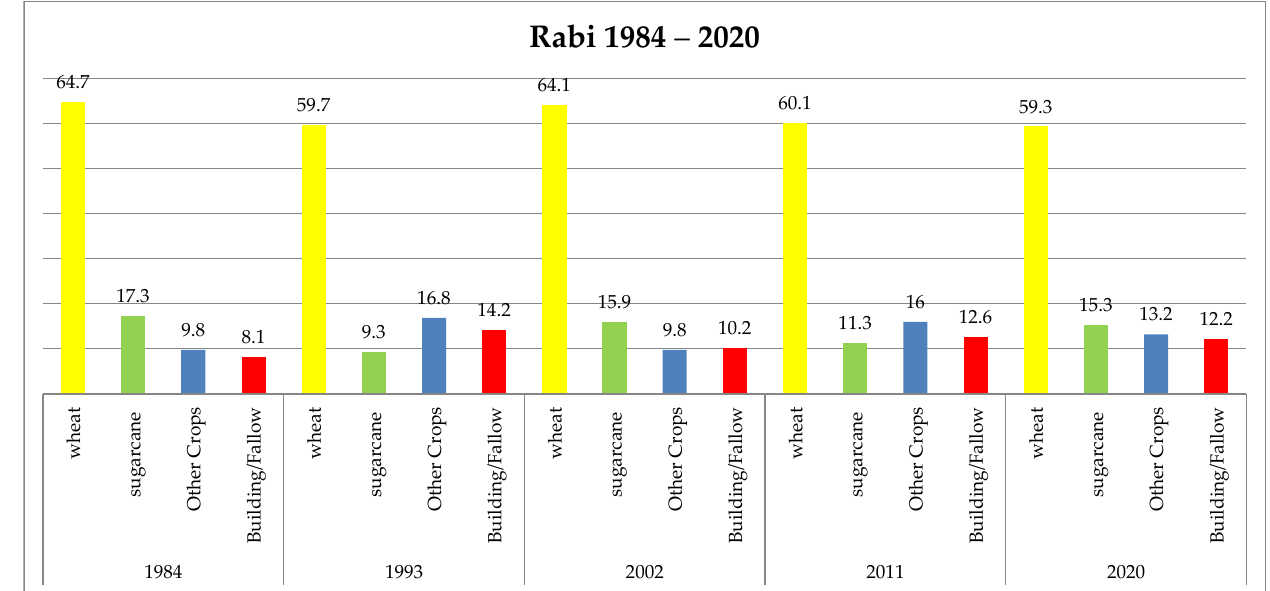
Figure 4. Crop identification map for Rabi season ( a ) 1984 ( b ) 1993 ( c ) 2002, ( d ) 2011 and ( e ) 2020.